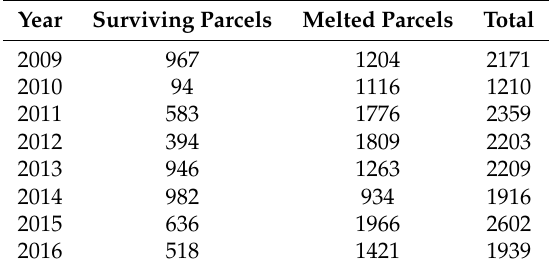
Figure 2. Example plots of four studied variables for melted ( red ) and surviving ( black ) parcels during 2009. Dotted lines indicate one standard deviation away from the main curve. Table 1. Number of melted and surviving parcels analyzed for each year of study.